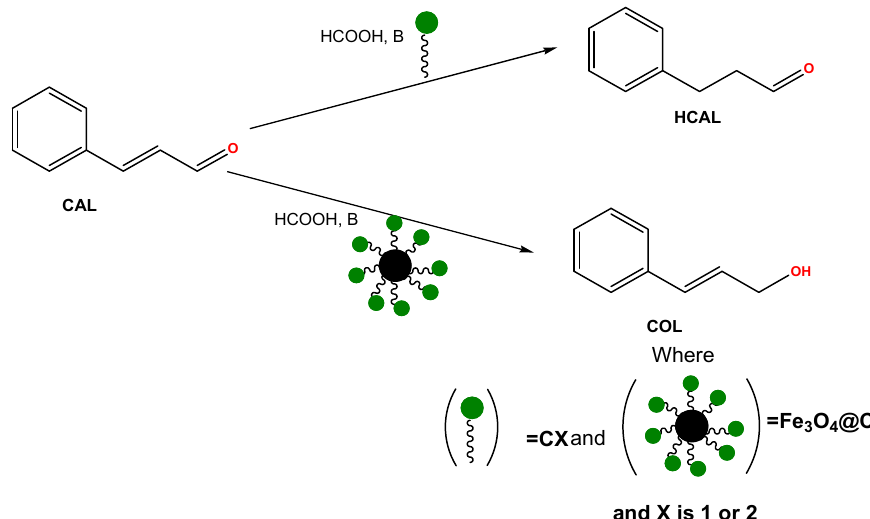
Scheme 3. General scheme for the transfer hydrogenation of cinnamaldehyde to hydro cinnamal- dehyde and cinnamyl alcohol using the synthesised catalyst